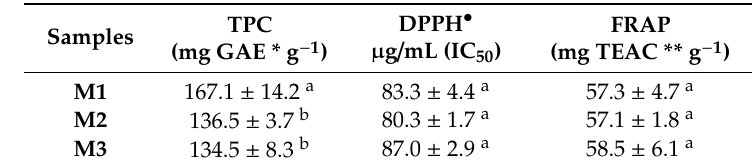
Table 3. Total phenol content of fully solubilized membranes by the Folin-Ciocalteau method and antioxidant activity by the 2,2-diphenyl-1-picrylhydrazyl radical (DPPH) and Ferric Reducing Antioxidant Power (FRAP)